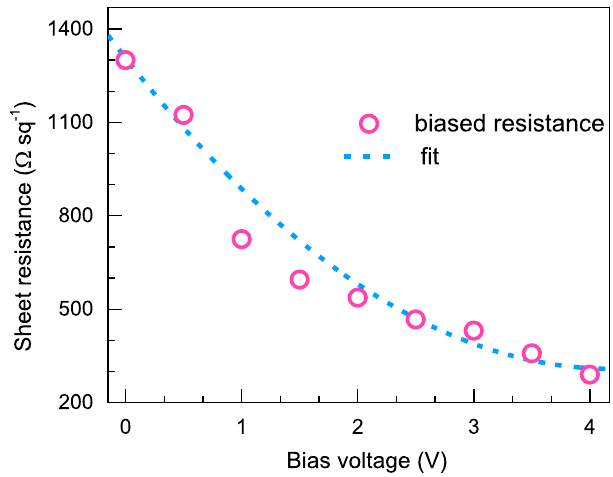
Fig. 2. Electrically biased sheet resistance of the graphene- sandwich structure under the different bias